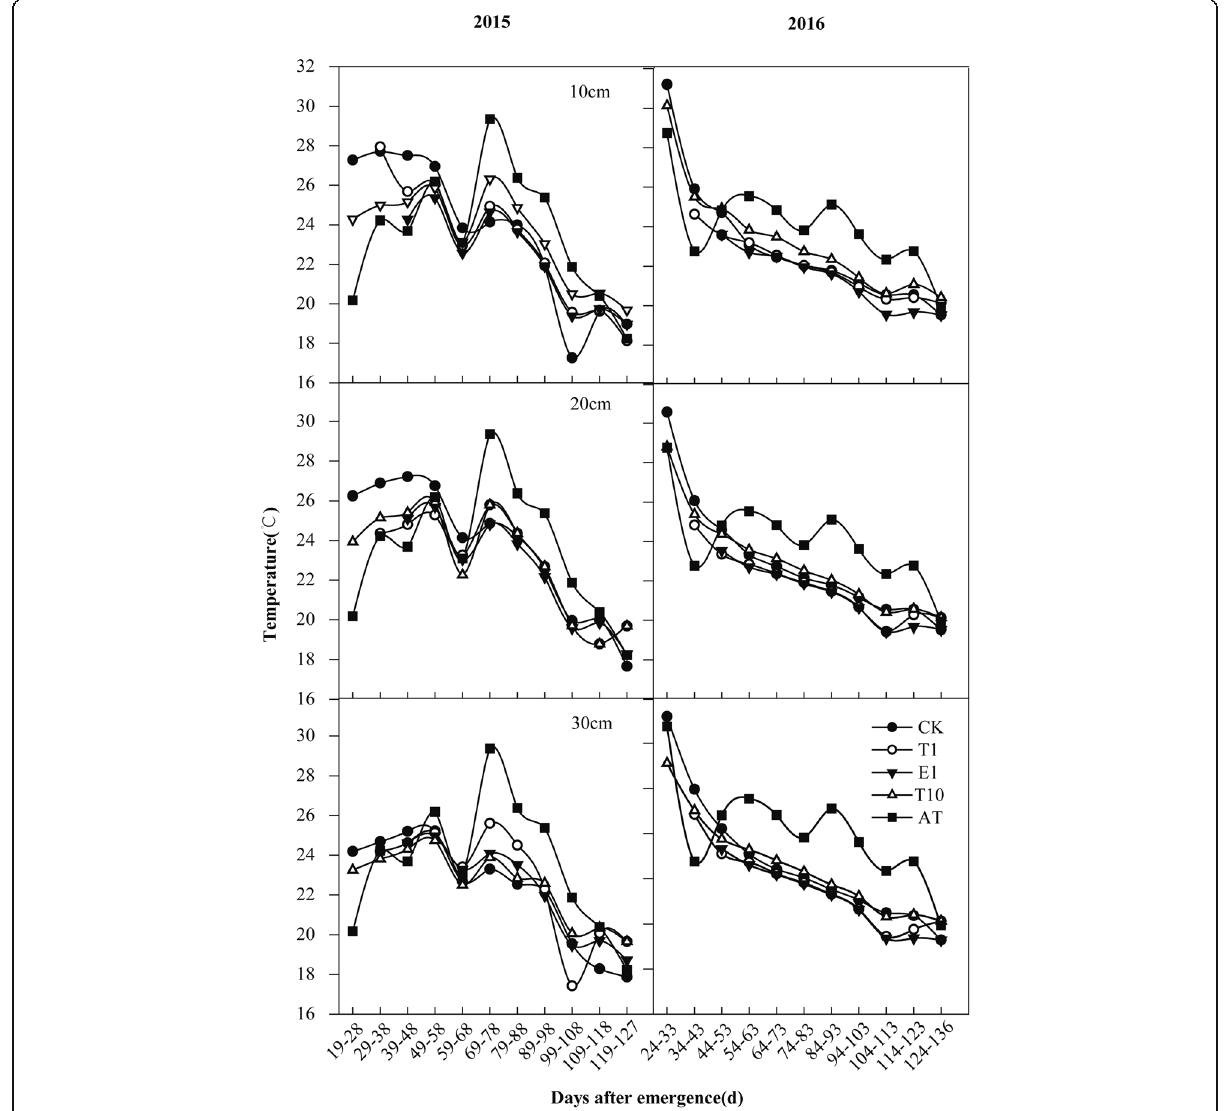
Fig. 2 Daily average soil temperature (°C) variation in various treatment groups: 1 and 10 days before the first irrigation (T1, T10, respectively) and 1 day before the second irrigation (E1) after seedling emergence, with one control group of film mulching present across cotton plant growth stages (CK) and soil depth layers (10, 20, and 30 cm) across growth stages during 2015 – 2016. AT is air temperature. A and D represent the removal of mulch 10 days before the first irrigation on May 25, 2015 and June 9, 2016, respectively. B and E represent the removal of mulching film on June 4, 2015 and June 19, 2016, respectively, one day before the first irrigation. C and F represent the removal of mulching film on June 14, 2015 and June 29, 2016, respectively, one day before the second